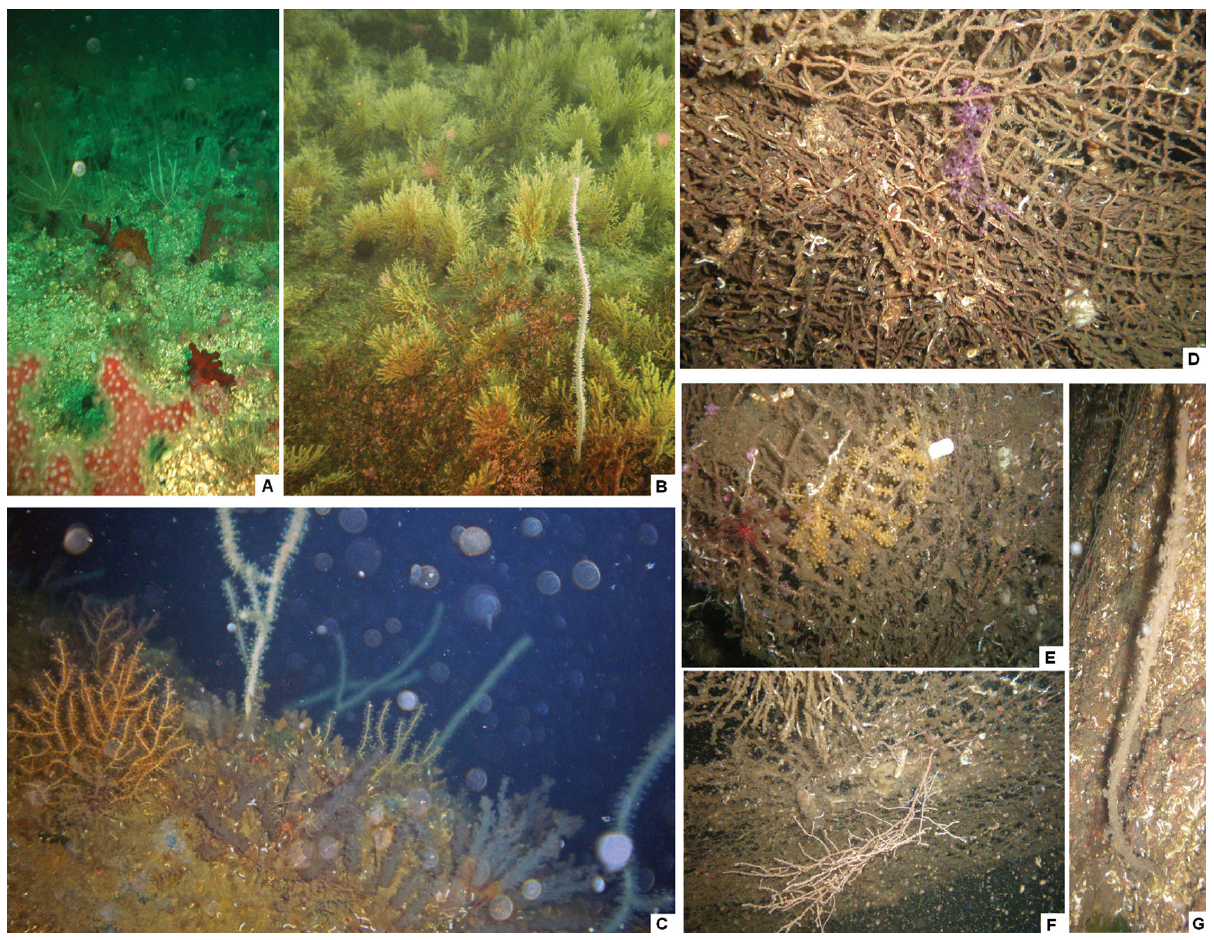
Fig. 4. – A. acaule assemblage at S1 station (A). E. cavolini dominated assemblage at N12 station. A S. klavereni colony is at the front of image (B). P. macrospina, S. klavereni , and P. spinulosum assemblage at station N5. The picture is covered with white spots due to the turbidity